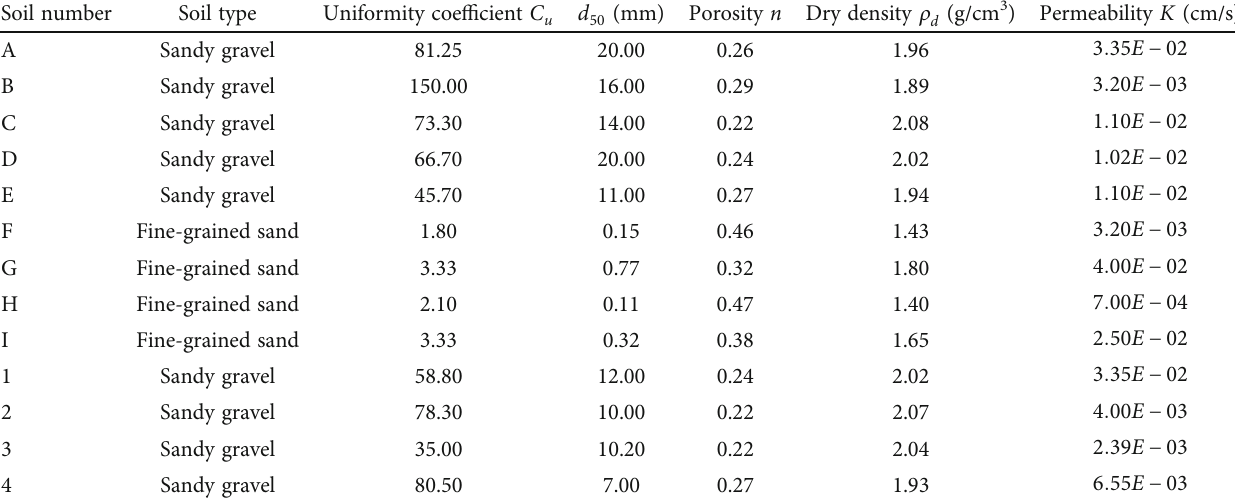
Table 1: Physical parameters of di ff erent soil samples.